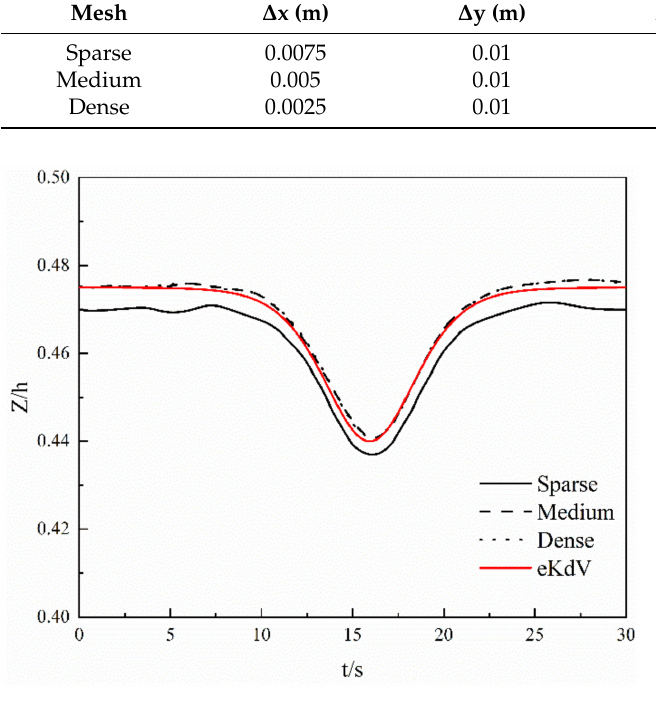
Figure 3. Mesh convergence analysis of waveforms.